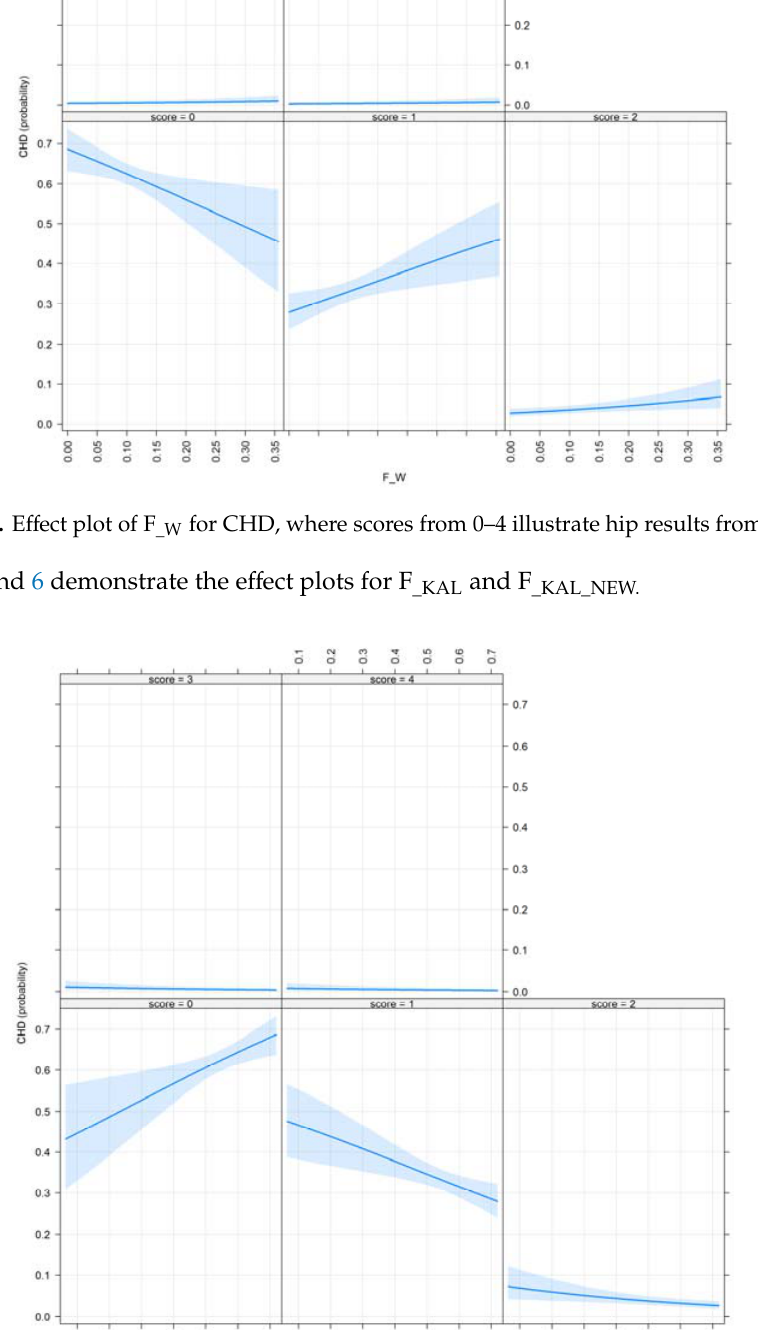
Figure 6. Effect plot of F _KAL for CHD. 3.2. Results of Purging in Canine Elbow Dysplasia For CED results, the tendencies were similar; however, the estimated values of classical inbreeding coefficient and the ancestral inbreeding defined by [26] did not show any significant differences ( p = 0.802, p = 0.425).